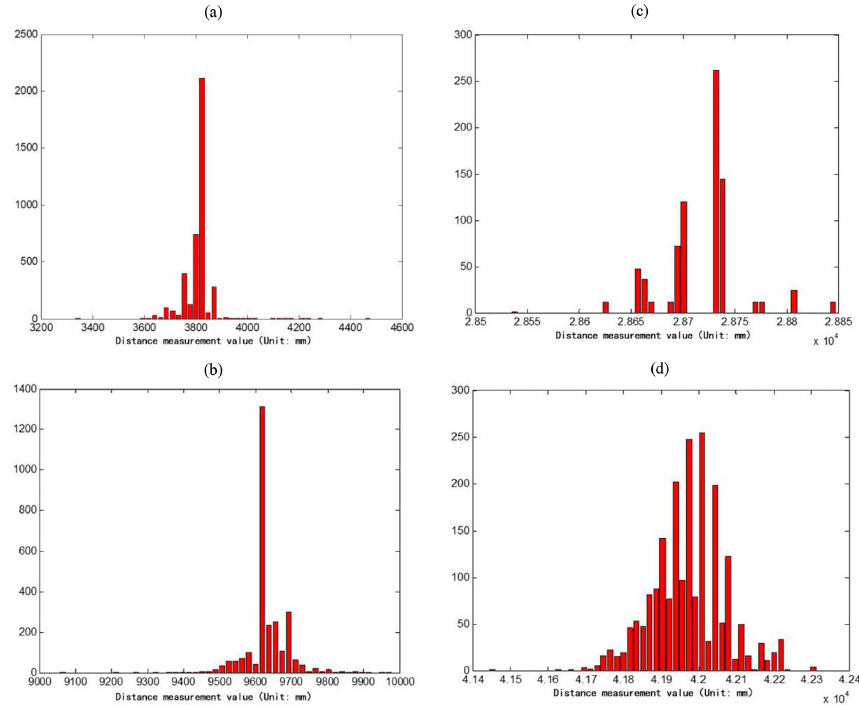
Figure 3. Histogram of the measured values at different distances. (a) Histogram of the measured value at 3560mm. (b) Histogram of the measured value at 9640mm. (c) Histogram of the measured value at 28220mm. (d) Histogram of the measured value at 41540mm.